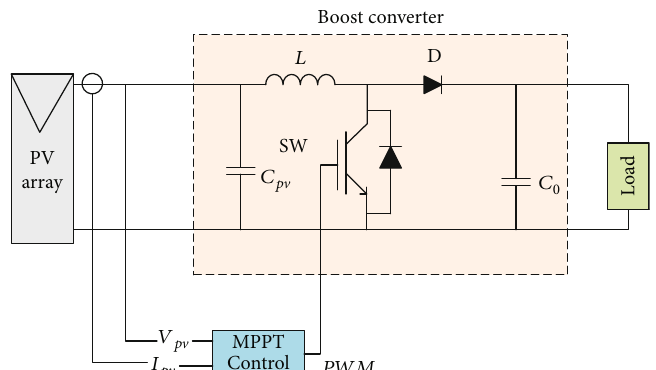
Figure 1: Photovoltaic system.